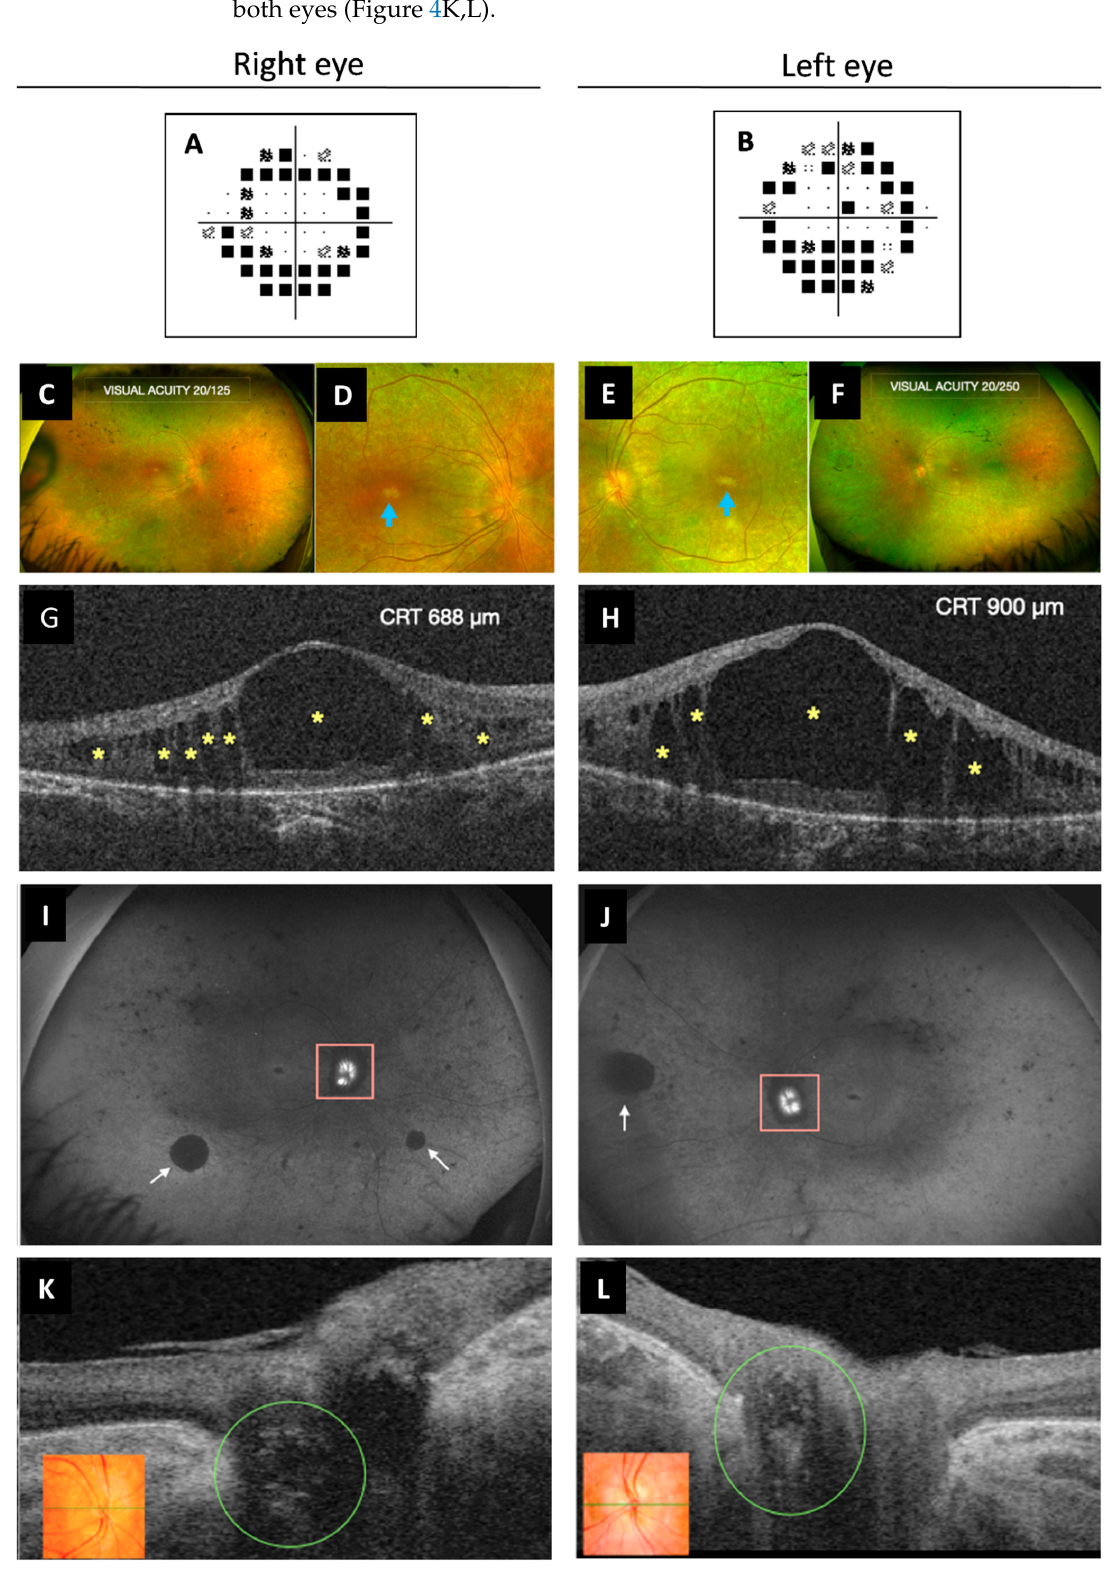
Figure 4. Multimodal imaging study of ophthalmological findings. ( A , B ) Automated campimetry revealed a concentric reduction in both eyes. ( C – F ) UWF fundus retinographies show clear